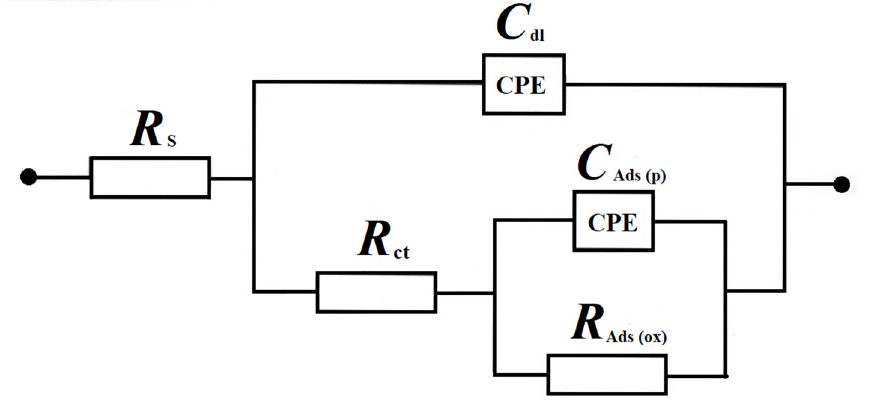
Figure 5. Equivalent circuit model used for fitting the obtained ac impedance spectroscopy data, where R s is solution resistance; C dl is double-layer capacitance; R ct is charge-transfer resistance parameter for electrooxidation of Fe anode surface; R Ads and C Ads are adsorption resistance and capacitance parameters for Fe(OH) 2 film, respectively; and R ox and C p are azo dyes electrooxidation resistance and pseudocapacitance parameters, respectively, connected with oxidative degradation of AM dye molecule. The circuits include constant phase elements (CPEs) to account for distributed capacitance.